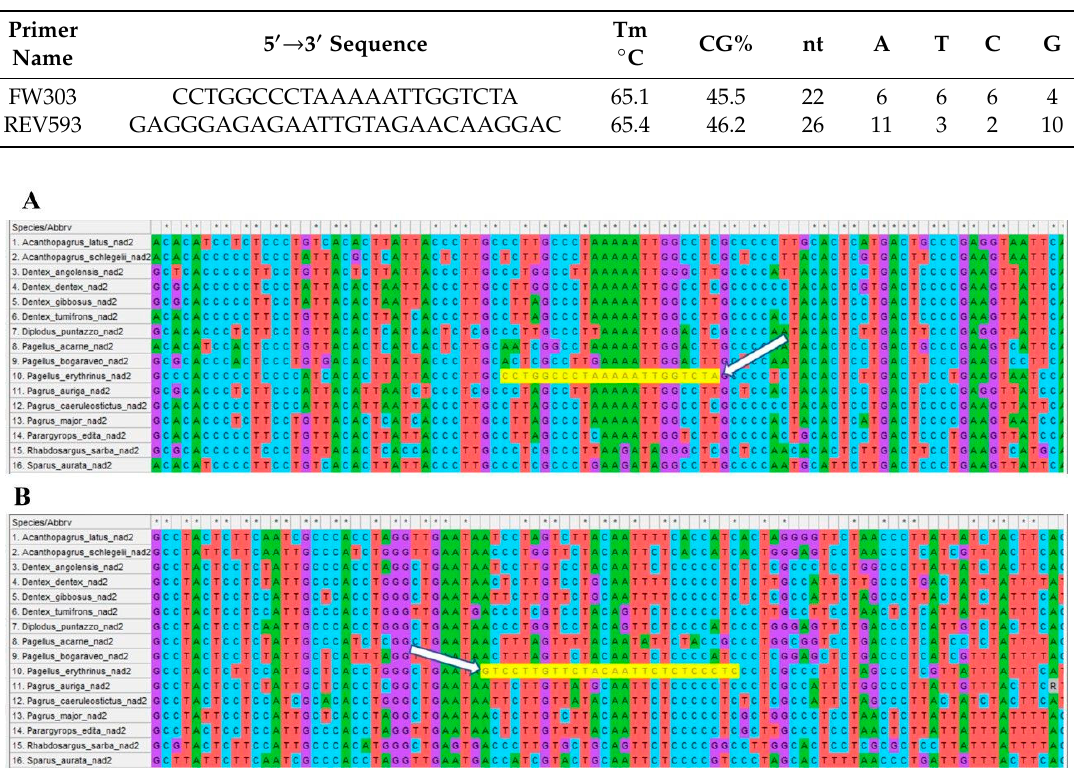
Figure 6. Species-specific primer alignment on Sparidae NAD2 orthologous genes. Primers (highlighted in yellow) aligned only in P. erythrinus (sample n. 10). White arrows show the 3 ′ end